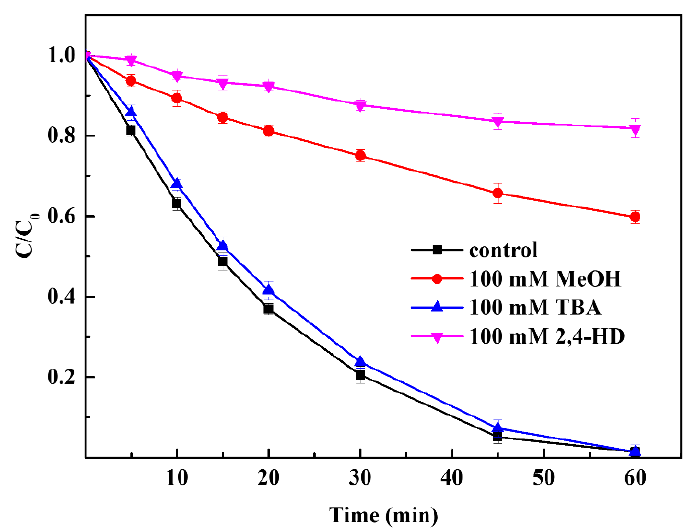
Figure 5. Effect of radical scavengers on Rhodamine B degradation (PAA = 80 mg/L, CuFe 2 O 4 = 100 mg/L, pH = 7, C 0 = 20 mg/L, room temperature for 1 h).